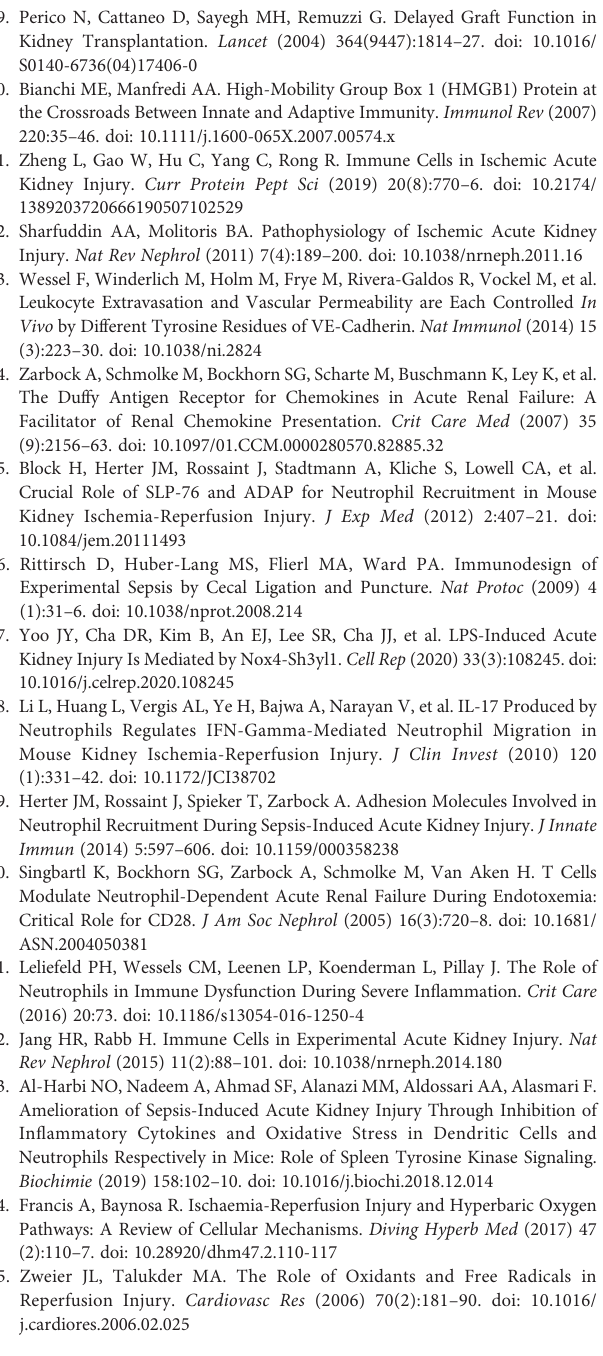
of healthy mice. AKI was induced in WT and VEC-Y731F mice by CLP or IRI and kidneys were enzymatically digested. Samples were stained with fl uorescent antibodies and analyzed in a FACSCantoII fl ow cytometer (BD). Cells were chosen by FSC-A/SSC-A and FSC-H/FSC-A size and singlets discrimination, respectively. CD45 + Ly-6G + Ly6B.2 + populations were considered as neutrophils and analyzed for Pe signals. Representative gating strategies for bone-marrow-derived (A) , peripheral blood-derived (B) and kidney-derived (C) neutrophils. Sytox + cells were chosen from a Ly-6G + population. Light orange: isotype control; deep orange: antibody